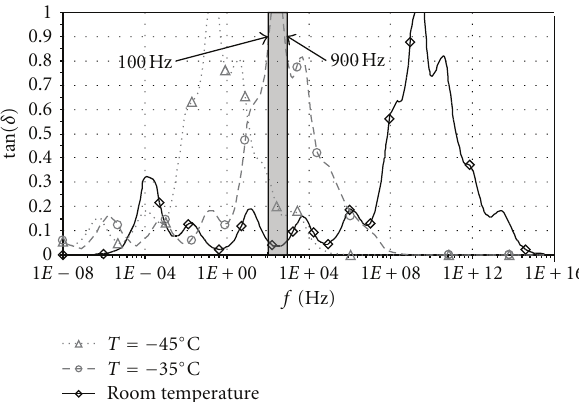
Figure 7: Storage modulus versus frequency curves of EPDM v2 in case of two di ff erent 40-term generalized Maxwell-model at room temperature (strain amplitude = 0.01%).